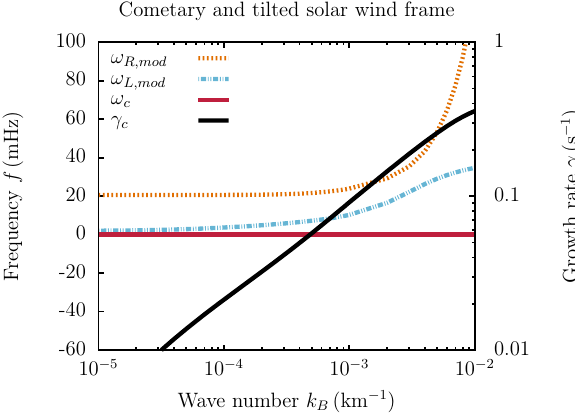
Figure 2. Wave propagation parallel to the ambient magnetic field B 0 . The frequencies and growth rates of the dispersion relation are shown. Since the Doppler shift does not affect this propagation, the same dispersion results from TSW and the cometary rest frame. The new mode regarding the water ions yields only a growth rate γ c (black) with an upper limit of γ c, res ≈ 0 . 42s − 1 but no frequency ω c (red), while the modified R- (orange) and L-modes (light blue) are ω R, mod and ω L, mod , respectively. The negative branches are not shown, since they are mirror symmetric to the k B